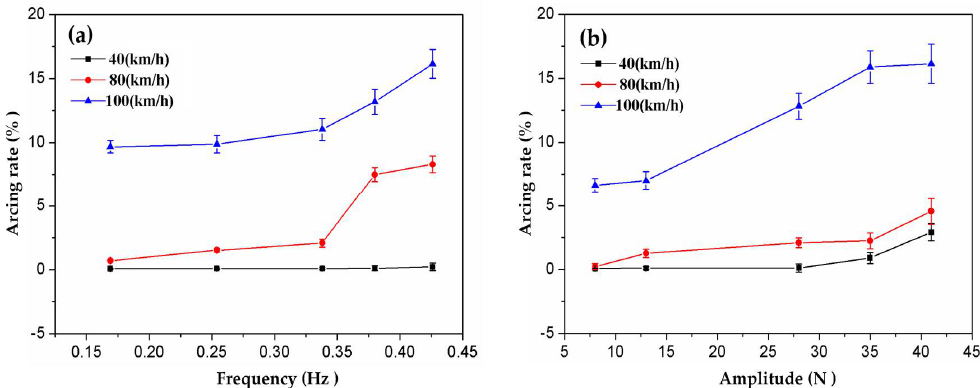
Figure 5. Arcing rate of the pure carbon strip varying with ( a ) frequency and ( b )